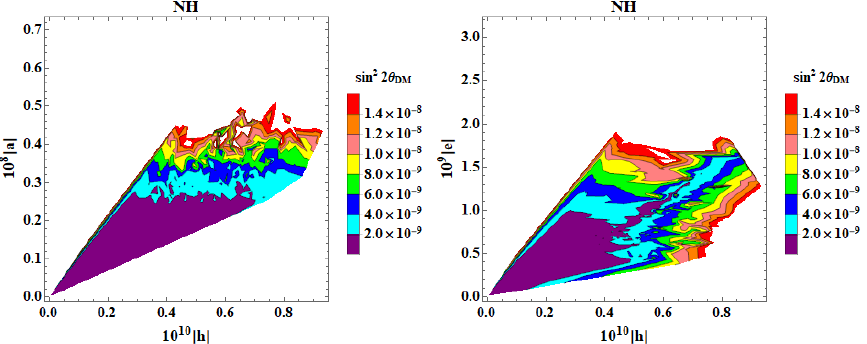
Figure 12 . Variation of di(cid:11)erent model parameters (in eV) with the DM-active mixing as the contour for normal hierarchy. The limit as predicted by cosmology is (10 (cid:0) 12 (cid:0) 10 (cid:0) 8